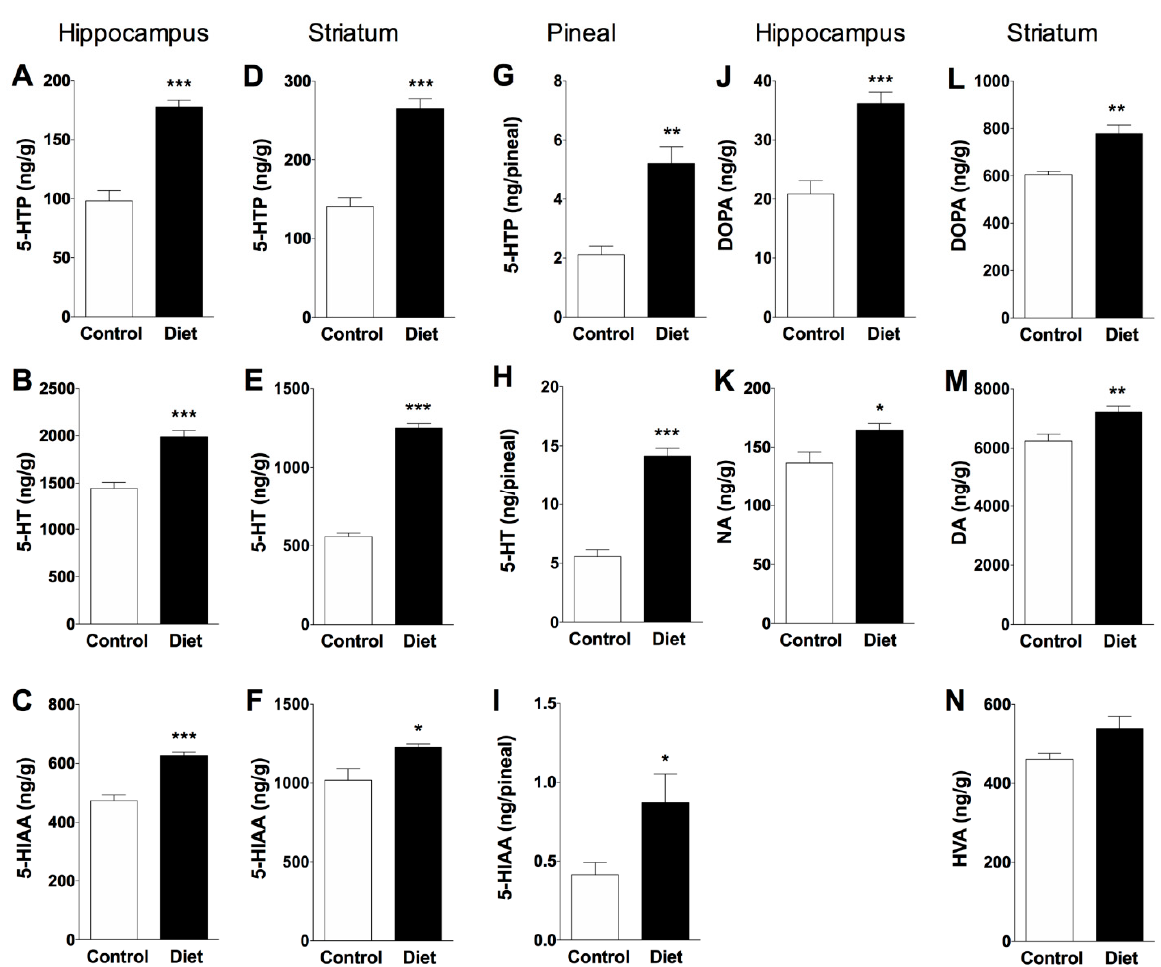
Figure 3. Effects of an antioxidant-enriched diet in serotonergic and catecholaminergic systems in hippocampus, striatum and pineal gland of old rats (20 months). Serotonergic system ( A – I graphs): Bars represent the mean ± SEM (ng/g of wet tissue) in hippocampus and striatum or ng/pineal in overall pineal gland) of 5-HTP accumulated during 30 min after decarboxylase inhibition, 5-HT tissue content, and 5-HIAA metabolite values. Catecholaminergic systems ( J – N graphs): Bars represent the mean ± SEM (ng/g of wet tissue) of DOPA accumulated during 30 min after decarboxylase inhibition, NA or DA tissue content in hippocampus and striatum, respectively, and HVA metabolite values in striatum. Unpaired t-test was used to statistical evaluation; * p < 0.05, ** p < 0.01, *** p < 0.001 when compared treated rats ( n = 6) and control group ( n =